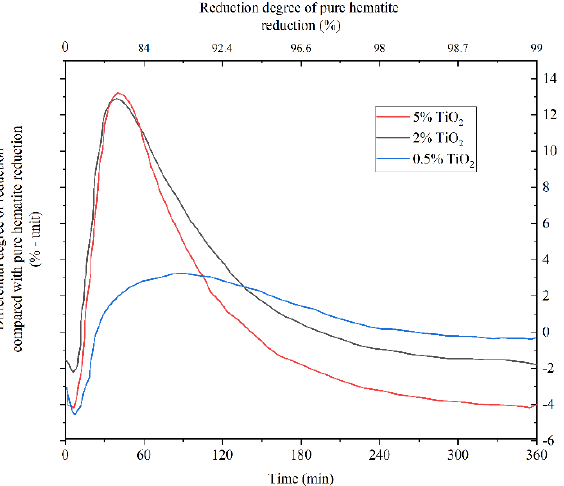
Figure 16. Effect of titanium dioxide on reduction of hematite. The curves show the difference from the reduction curve of pure hematite. The grade of reduction for pure hematite can be read from the secondary x-axis at the top of the figure [53] “modified”.